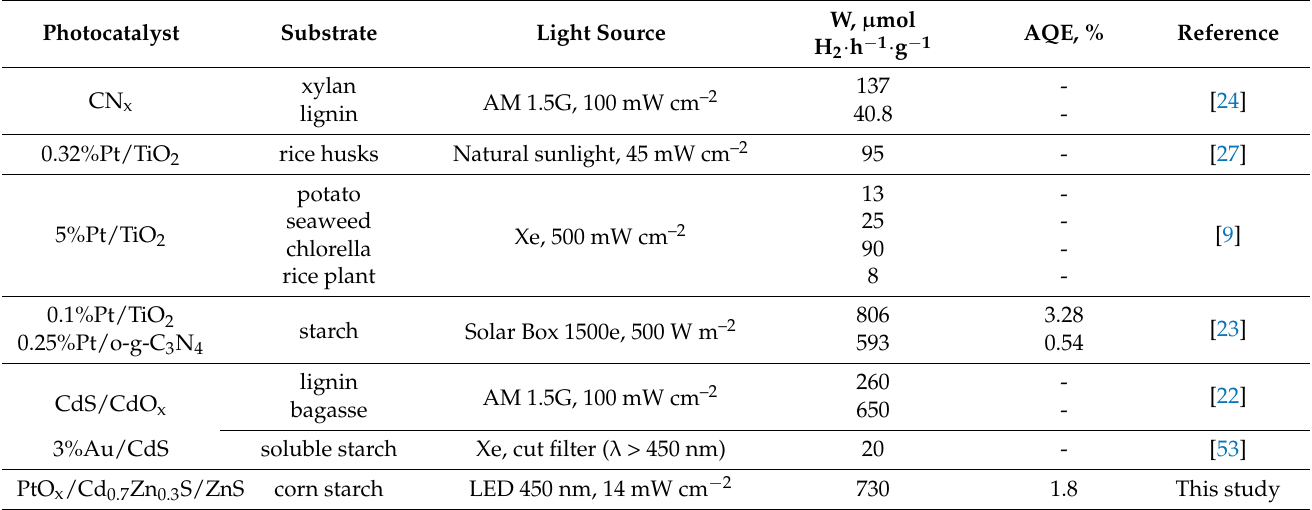
Table 1. Comparison of H 2 evolution rate from raw biomass